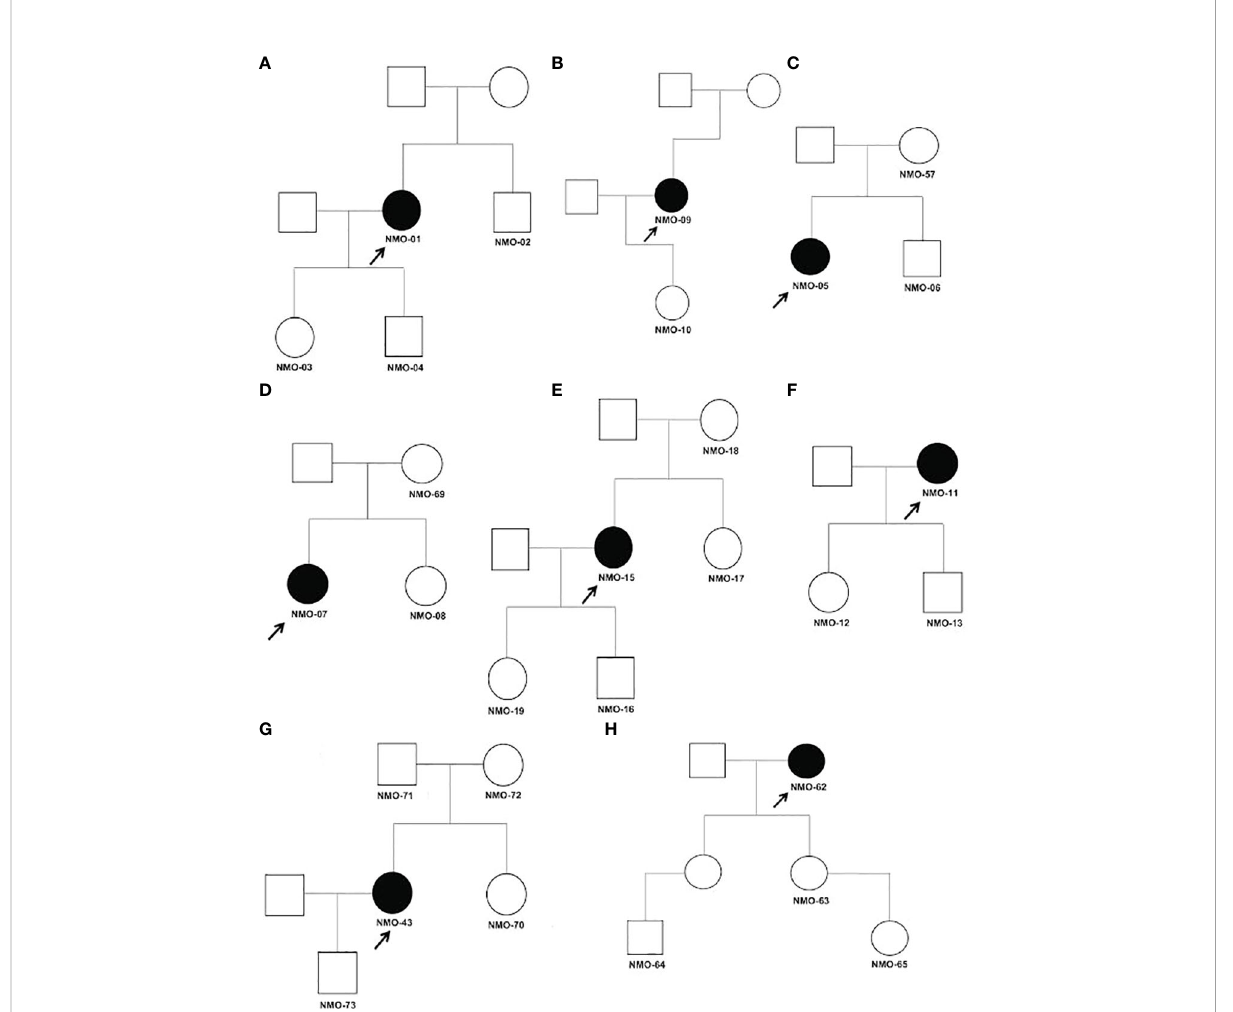
FIGURE 2 (A – H) Pedigrees of tested relatives and probands for trio analysis. Affected individuals are shaded black and probands are indicated by arrows. All individuals tested in our analysis are indicated by their assigned number. Males are represented by squares and females by circles. Detailed clinical data for each family described in Supplementary Table